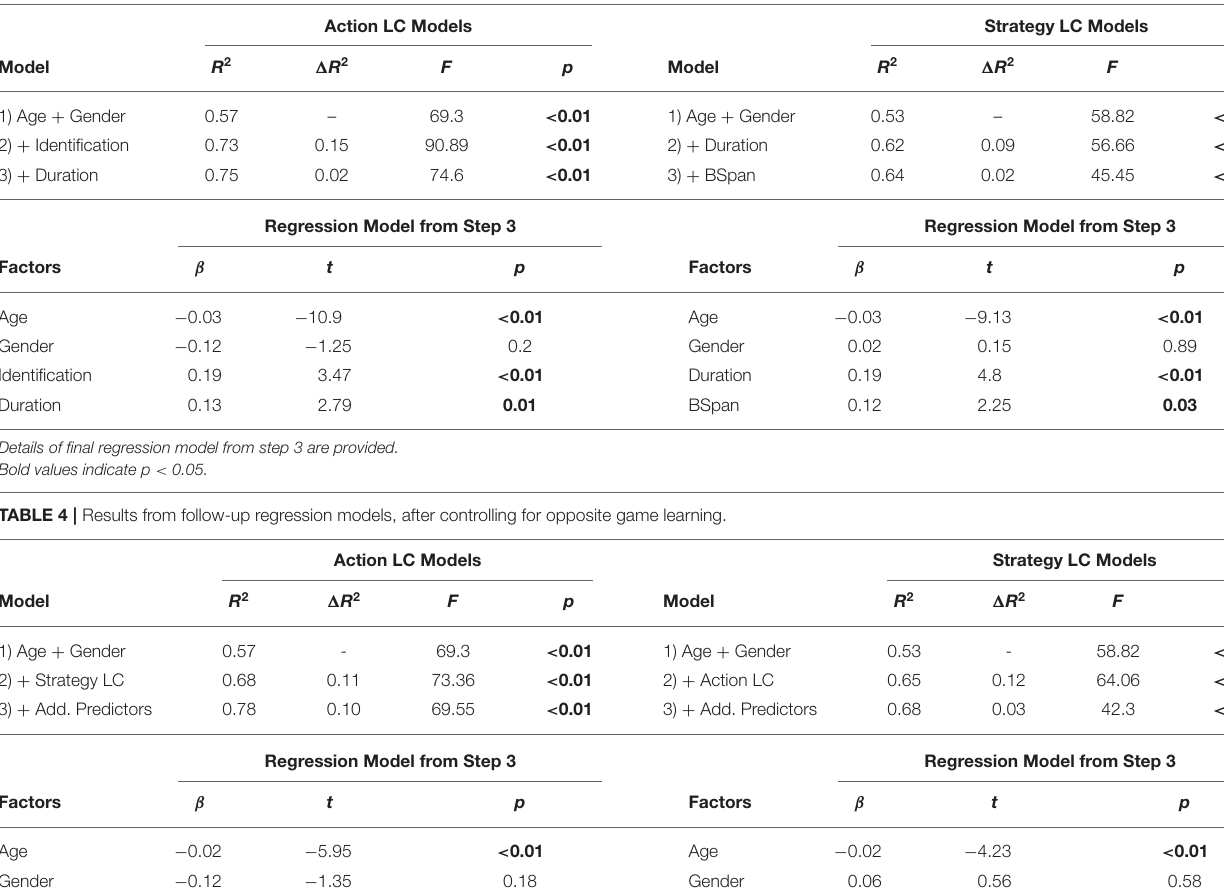
TABLE 3 | Results of stepwise regression across 3 steps.